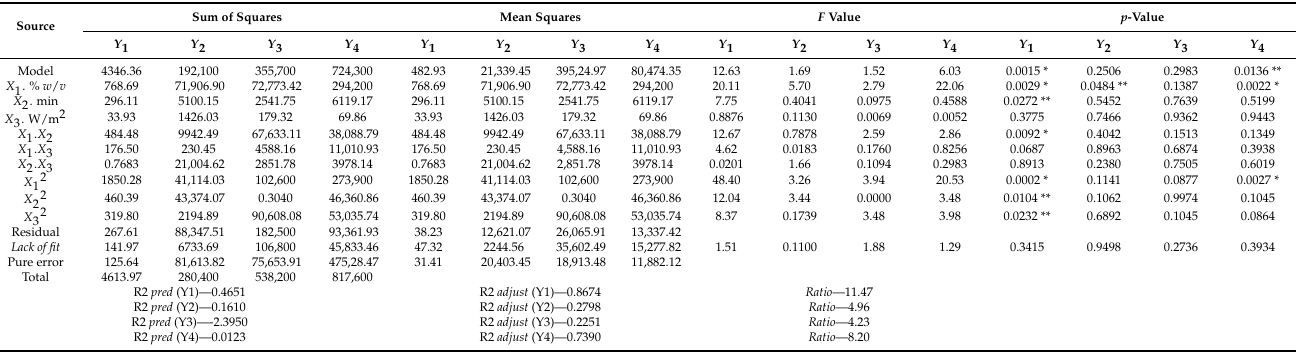
Table 2. Model summary and analysis of variance (ANOVA) of TPC, ABTS, DPPH and FRAP of the kiwiberry leaf